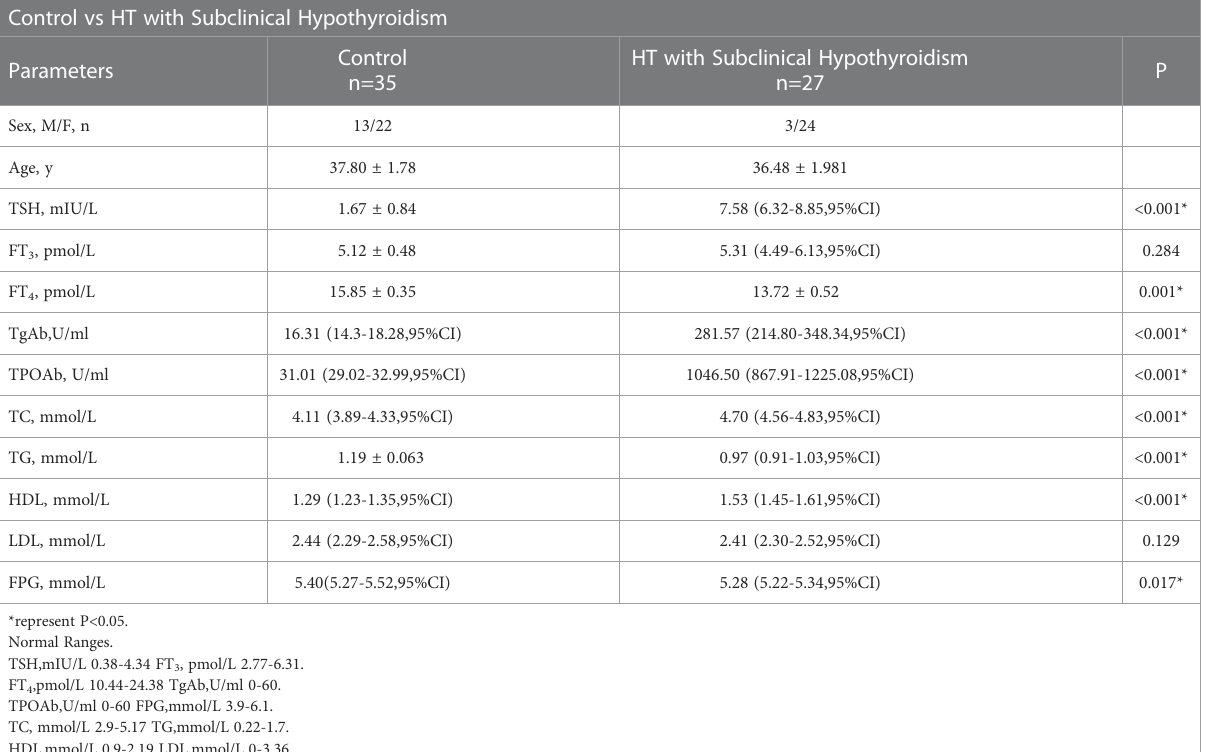
TABLE 2 The clinical baseline parameters of the control and HTS group. Control vs HT with Subclinical Hypothyroidism